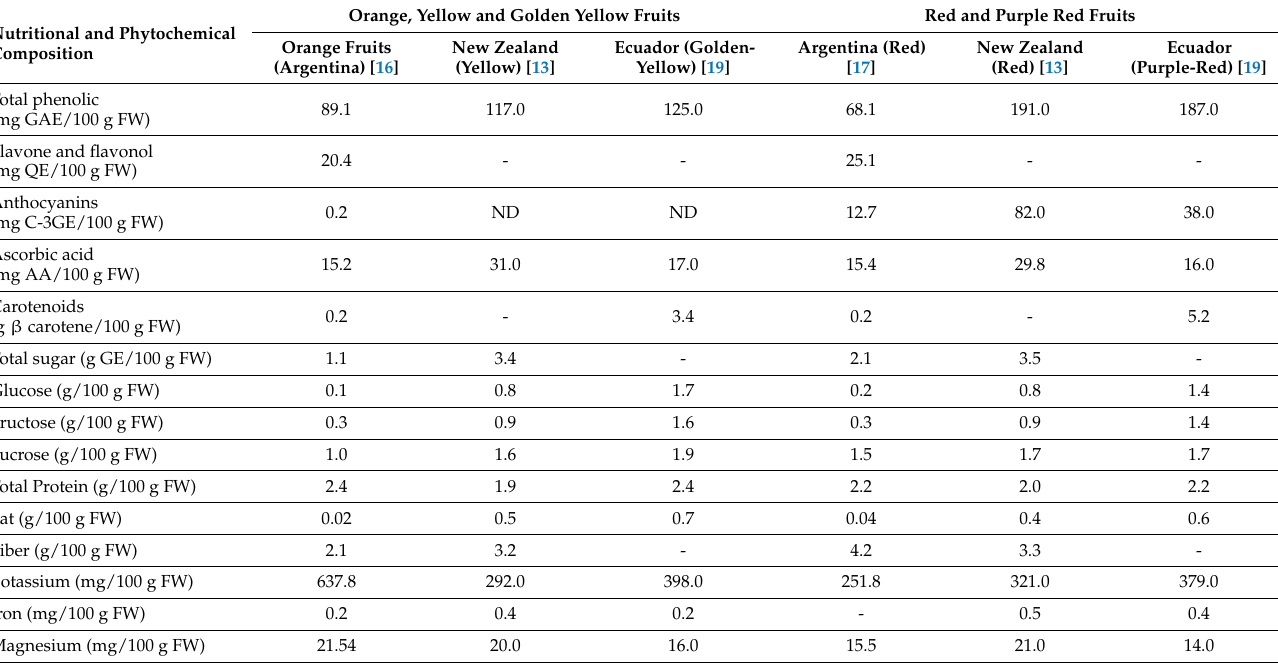
Table 1. Phytochemical and nutritional composition of different varieties of S. betaceum